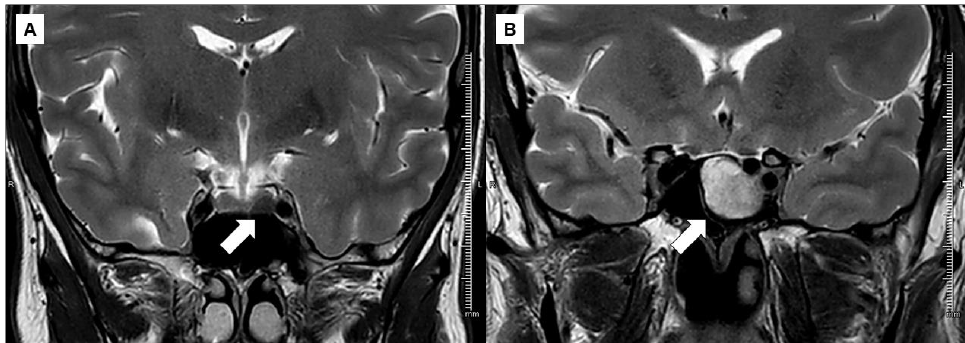
Figure 2. Radiological images showing two example cases. Left a markedly hypointense somatotroph adenoma in T2-weighted MRI scans ( A ). By way of comparison, a hyperintense somatotroph adenoma in T2-weighted MRI scans ( B ) is shown on the right.